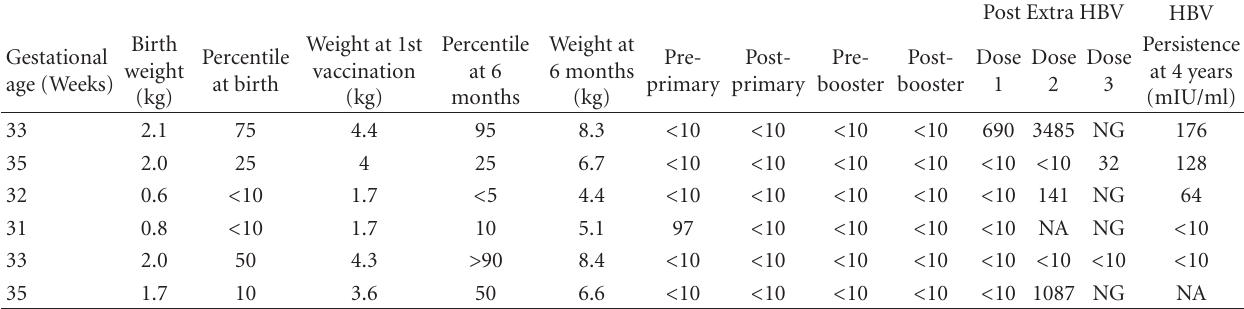
Table 5: Anti-HBs concentrations (mIU/ml) after all HBV doses in subjects who were non-responders to hepatitis B at the end of the primary and booster